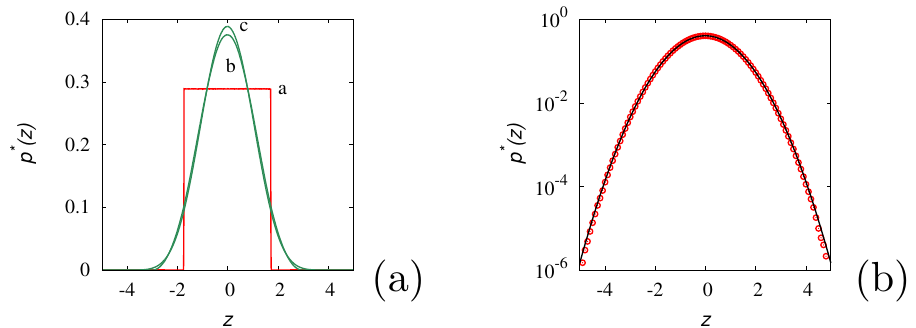
Figure 6. p ∗ ( z ) vs. z obtained from Monte Carlo simulations of the IFS Equation (31) at different values of α . Panel ( a ): line (a) refers to α = 1/2, line (b) to α = 0.8, line (c) to α = 0.9. Panel ( b ): symbols ( ◦ ) to α = 0.99. The solid line represents the normal